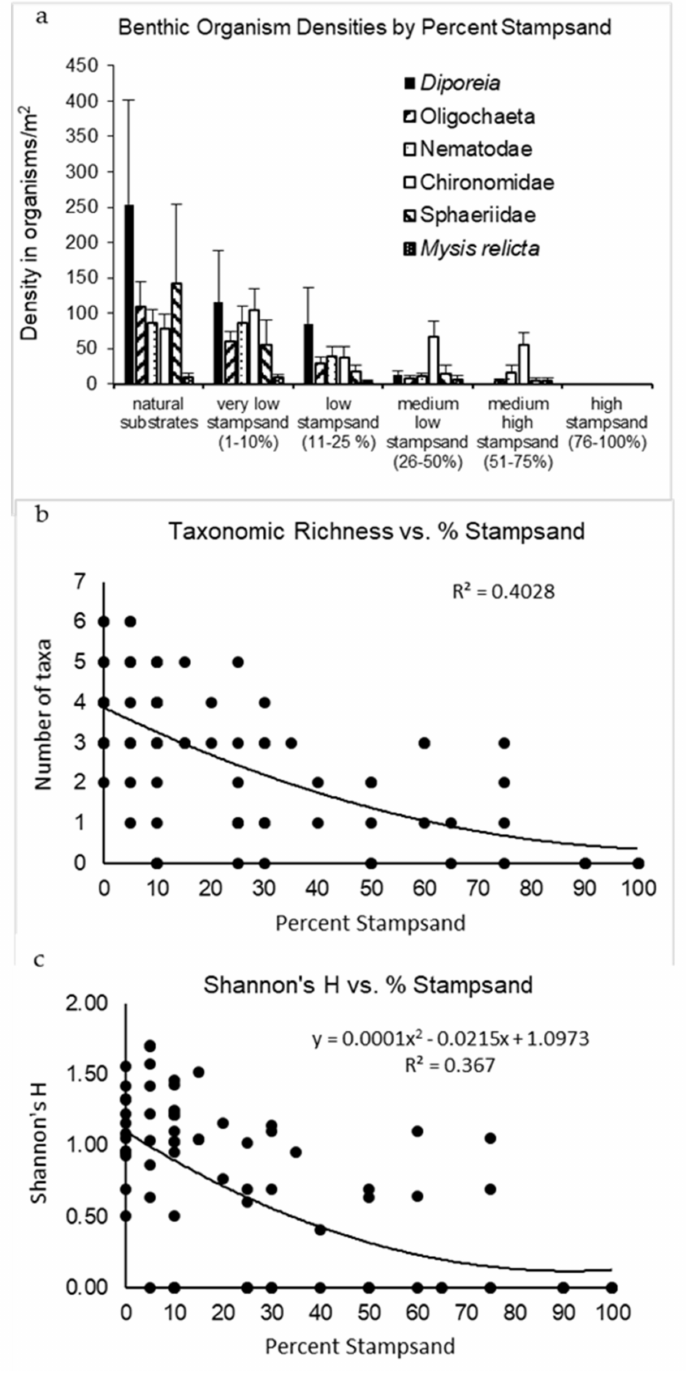
Figure 12. Effect of stamp sand percentage on benthic invertebrates: ( a ) Ponar samples document a major decrease in benthic organism density associated with an increase in % stamp sand. The bars give mean density (numbers/m 2 ) with 95% C.L. ( b ) Taxonomic richness plotted against percentage stamp sand (second degree polynomial regression with R 2 value). ( c ) Shannon’s H plotted against percentage stamp sand (second degree polynomial regression with R 2